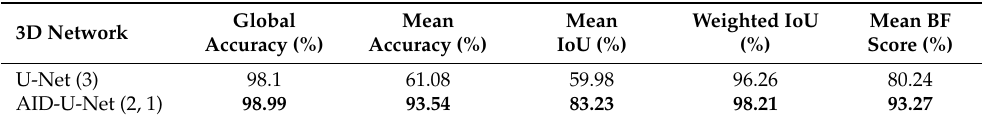
Table 8. Comparison between semantic segmentation results achieved by U-Net(3) and proposed AID-U-Net(2,1) for 3D prostate detection.